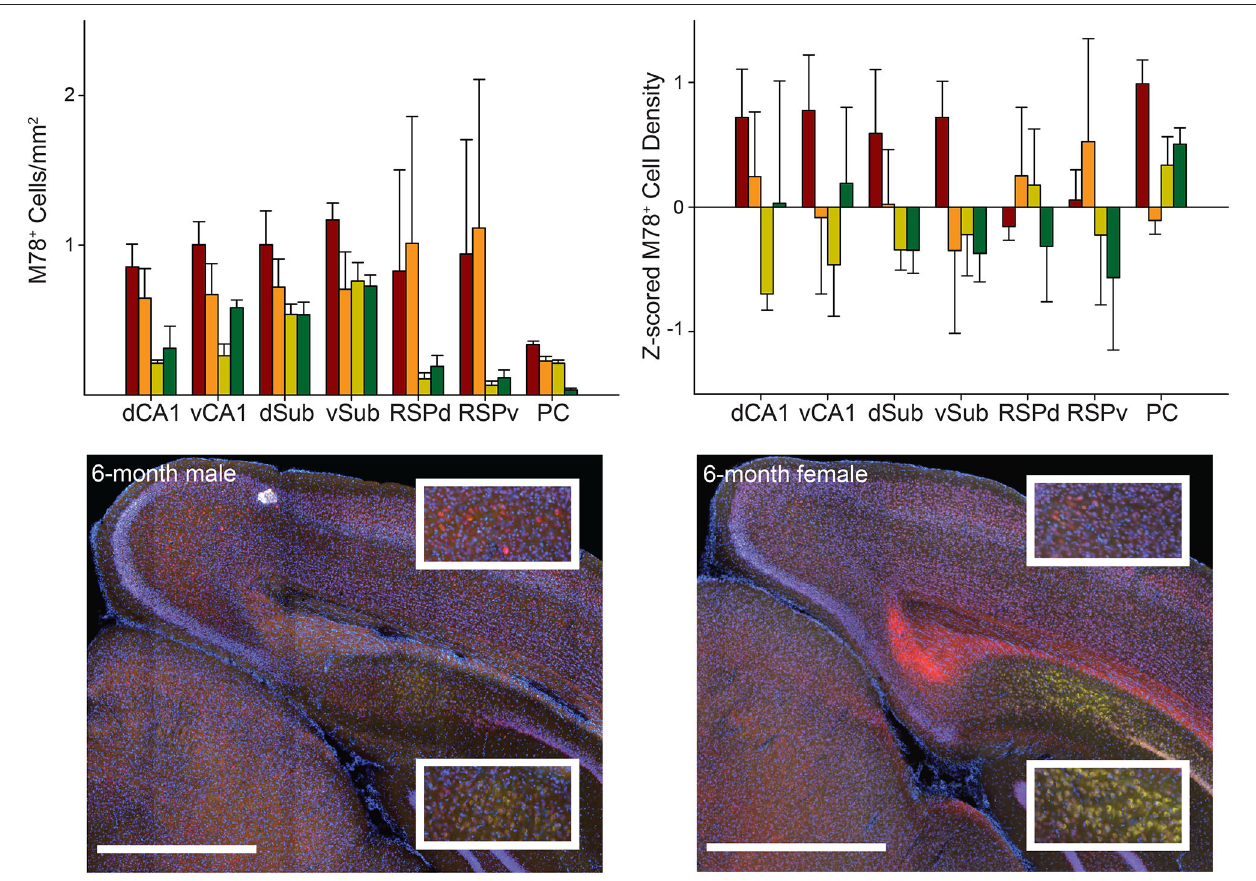
FIGURE 3 | M78 staining did not significantly vary across groups or brain regions. Top . M78 positive cell density ( left ) and Z-scored density ( right ) for each of the seven brain regions and four groups of mice. Bottom. Representative images showing M78 staining (green) in RSPd (Top Insets) and dCA1 (Bottom Insets) for 6-month male ( left ) and female ( right ) 3xTg-AD mice. Sections were also stained with NeuN (red) and DAPI (blue). Ventral CA1 (vCA1), Dorsal Subiculum (dSub), Ventral Subiculum (vSub), Ventral Retrosplenial Cortex (RSPv), and Parietal Cortex (PC). Scale bar = 1mm.